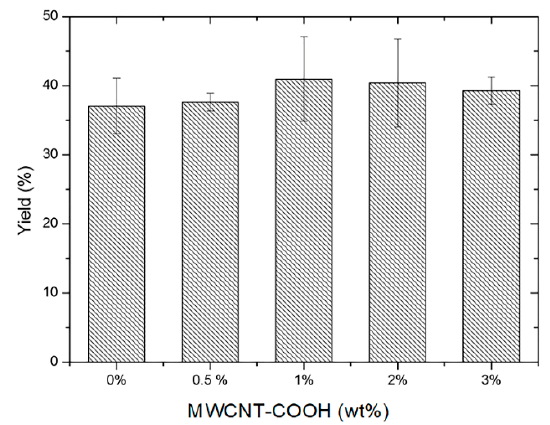
Figure 3. Reaction yield for the PNIPAM/MWCNT-COOH hydrogel synthesis with different nanotube concentrations.